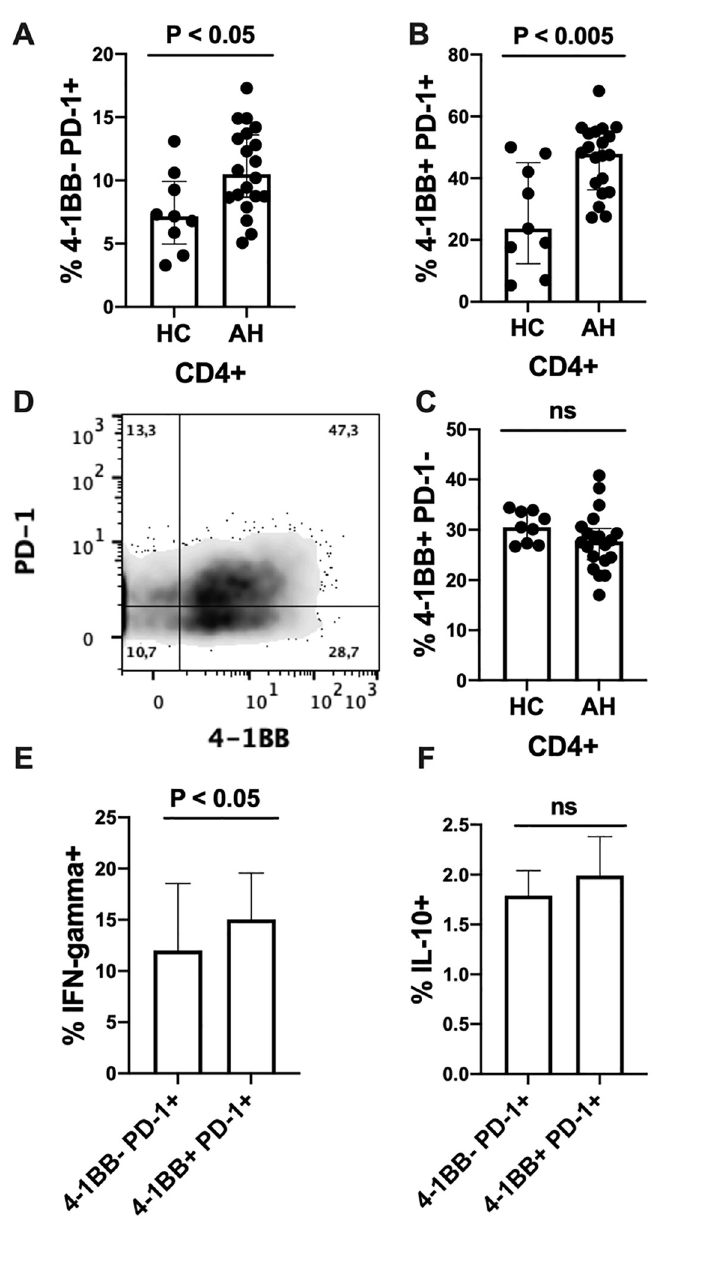
Fig 3. 4-1BB in relation to PD-1 expression. Flow cytometry of peripheral blood mononuclear cells stimulated for 48 hours with anti-CD3 and anti-CD28. (A-C) CD4 + T Lymphocyte were co-stained for 4-1BB and Programmed Death receptor (PD)-1 and frequencies of subgroups are reported for healthy controls (HC) and patients with alcoholic hepatitis (AH) at the day of diagnosis. The frequencies of (E) interferon- γ (IFN- γ ) and (F) interleukin-10 (IL-10) in the subgroups. All data analysed for differences between groups using unpaired (A-C) and paired (E-F) T test. All graphs shown as median ± interquartile range.